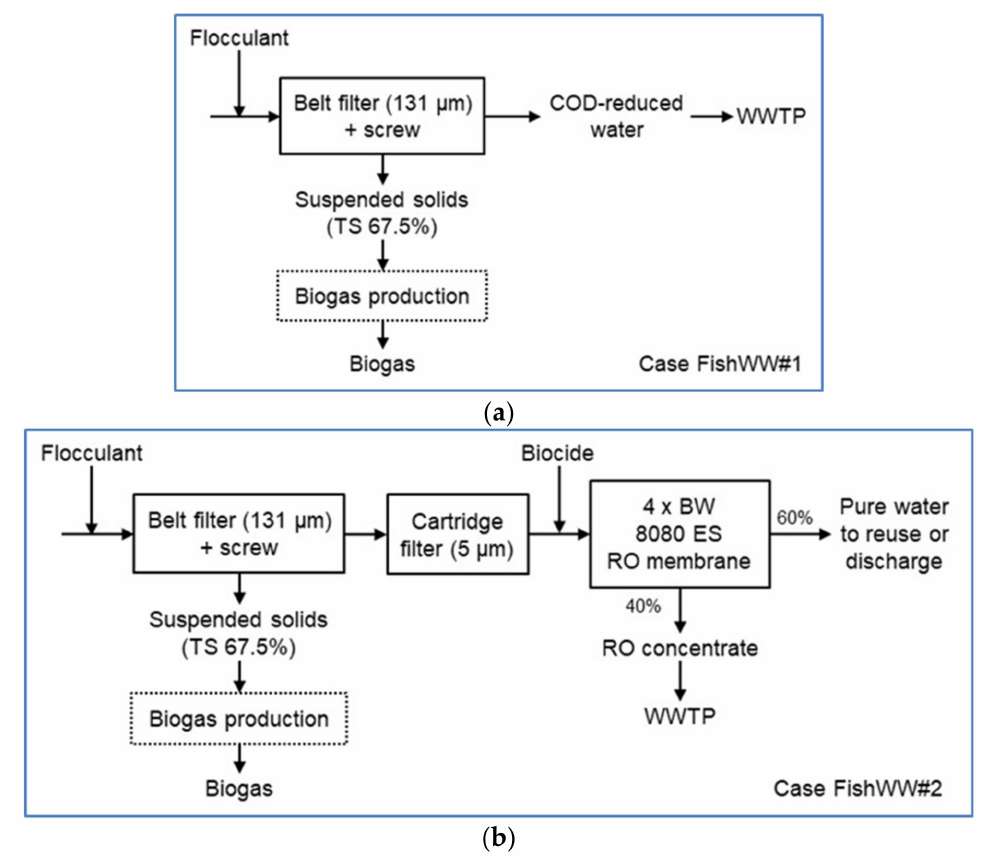
Figure 2. ( a ) Block diagram for cases FishWW#1 and ( b )